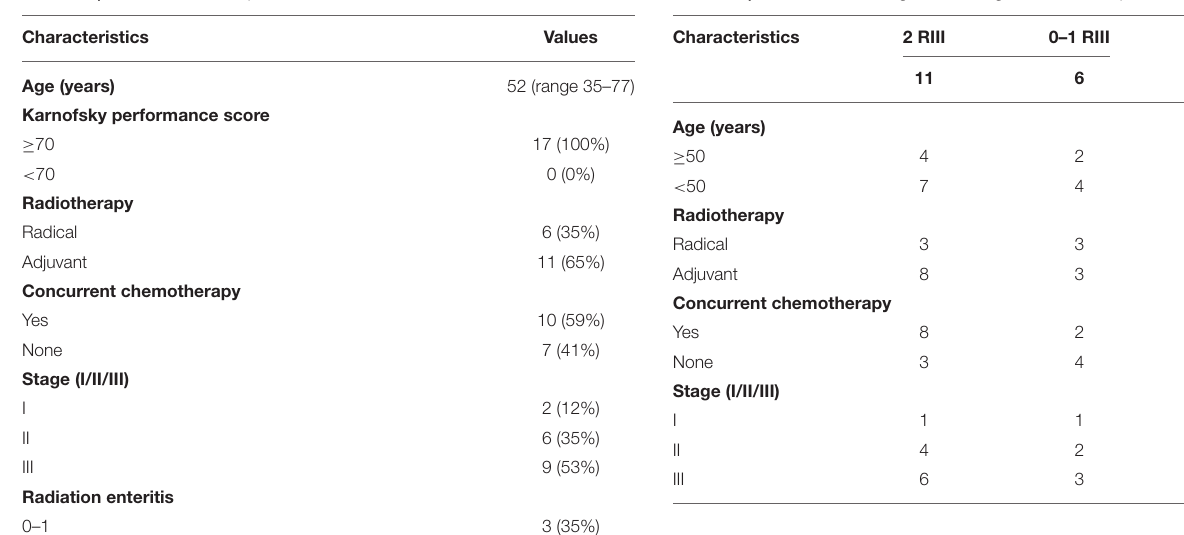
TABLE 1 | Clinical features of patients. TABLE 2 | Clinical features of grade 2 and grade 0 or 1 RIII patients.